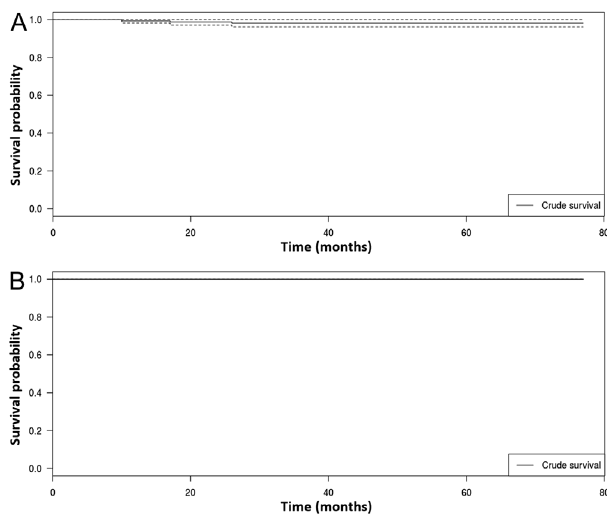
Figure 3. Survival analysis of the acetabular cup. (a) Global and (b) excluding septic etiologies.